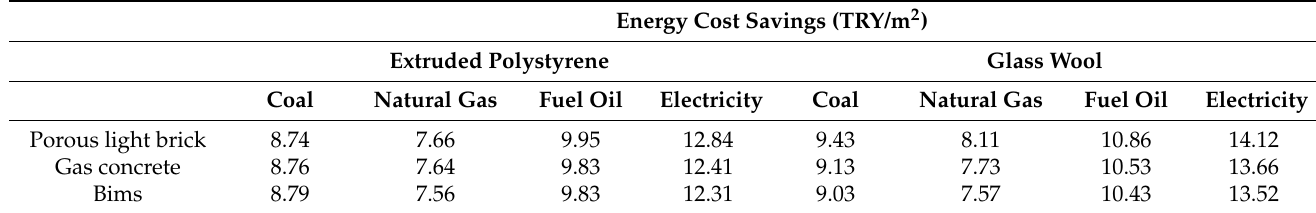
Table 8. Energy cost savings depending on fuel and insulation materials for wall types.